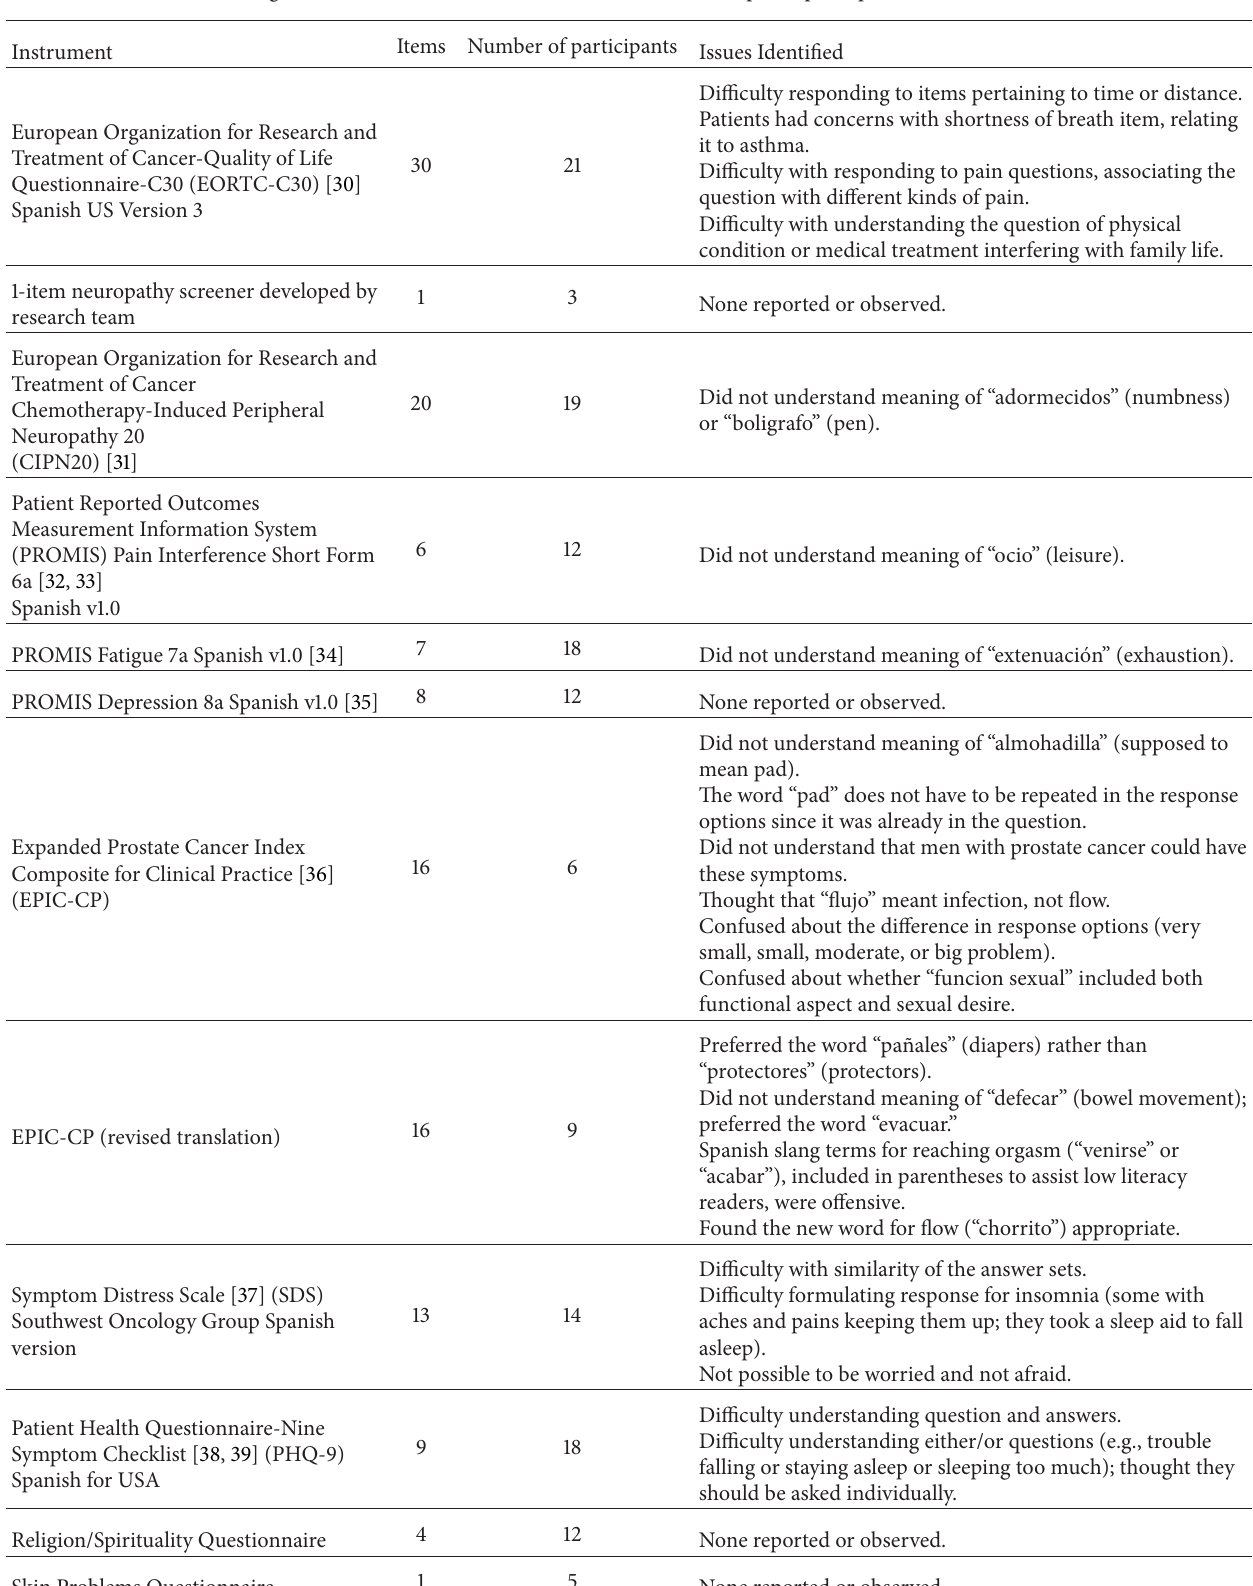
Table 4: Cognitive interview results: instruments, items, number participants per instrument, and